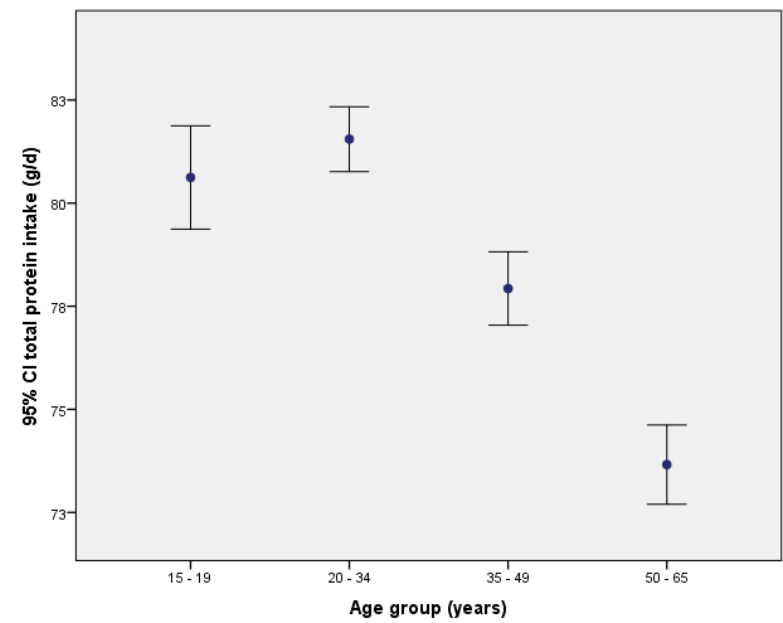
Figure 2. Mean protein intake by age group.